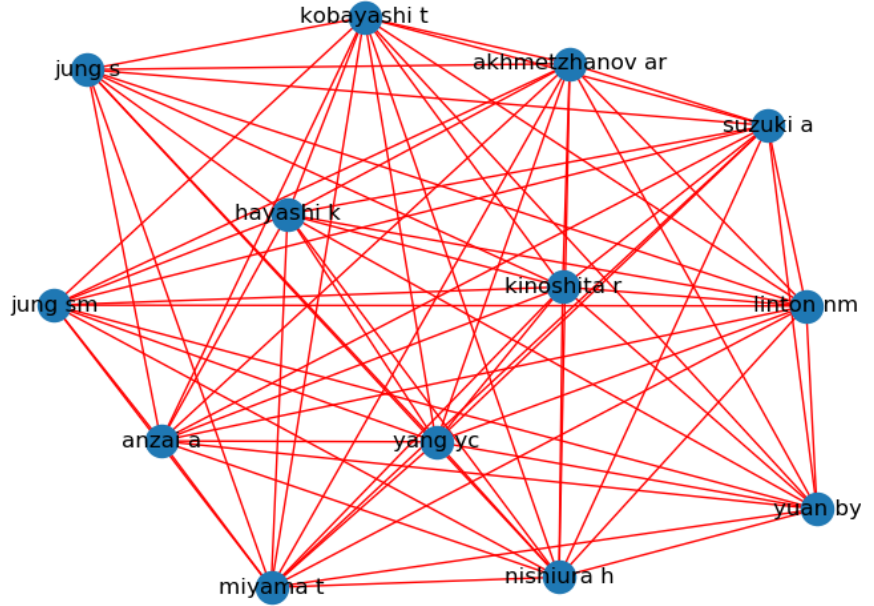
Figure 4. The author community with the largest number of published articles when the authors of all articles in February are interconnected. The actual author’s name is marked on each point, and the red edge is used to connect the points in the